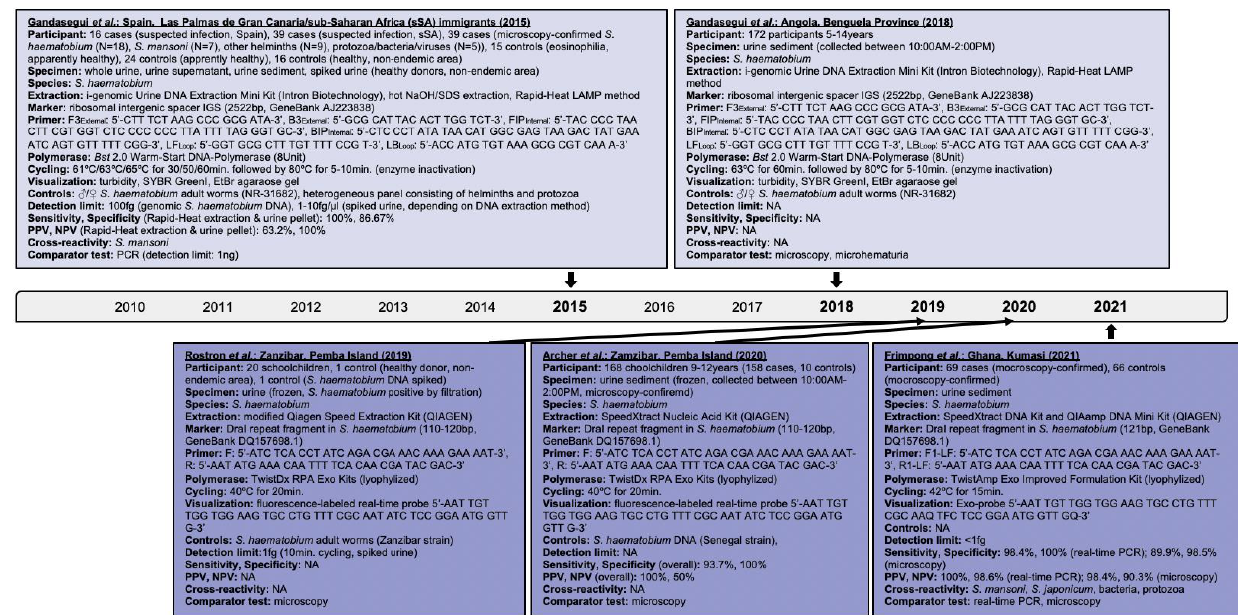
Figure 3. Articles identified on the isothermal diagnosis of Schistosoma haematobium with details on participants, specimens, assay features, and test evaluation in terms of detection limits, sensitivity, specificity, PPV and NPV versus a comparator test by chronological order of publication date. Articles highlighted in light blue delineate schistosomal diagnosis based on loop-mediated isothermal amplification (LAMP) while articles highlighted in blue delineate schistosomal diagnosis based on recombinase polymerase amplification (RPA). We searched databases of PubMed, Embase